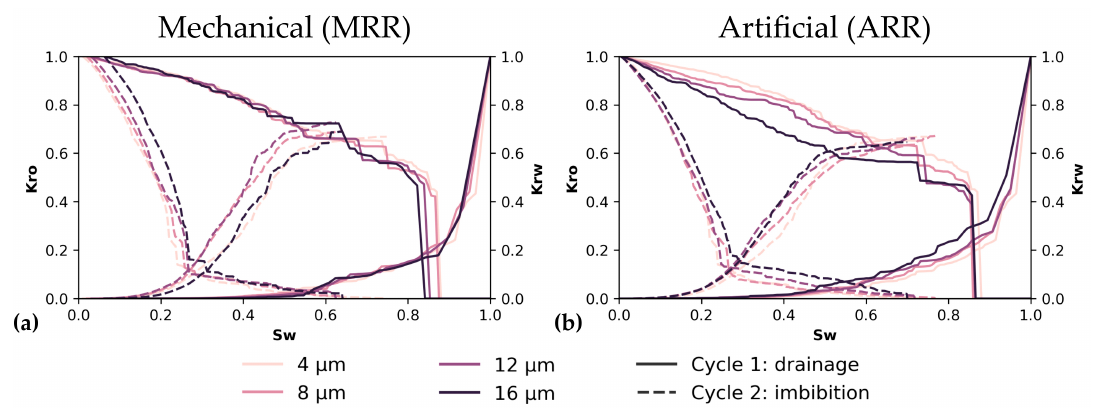
Figure 11. Resolution influence on relative permeability evolution of oil (K ro ) and water (K rw ) with varying water saturation (S w ) during oil-flooding (drainage) and water-flooding (imbibition). K ro decreases with increasing water saturation and K rw increases. a shows the evolution of relative permeabilities for the same volume at four different resolutions obtained from Mechanical Resolution Reduction (MRR) and in b this is shown for Artificial Resolution Reduction (ARR).